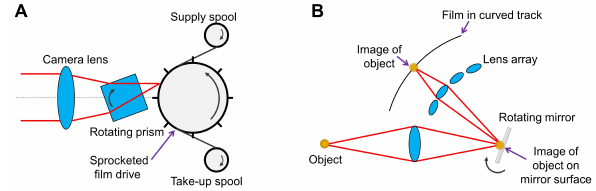
Fig. 3. Principles of film-based photography. (A) Rotatory-prism- based system. (B) Rotatory-mirror-based